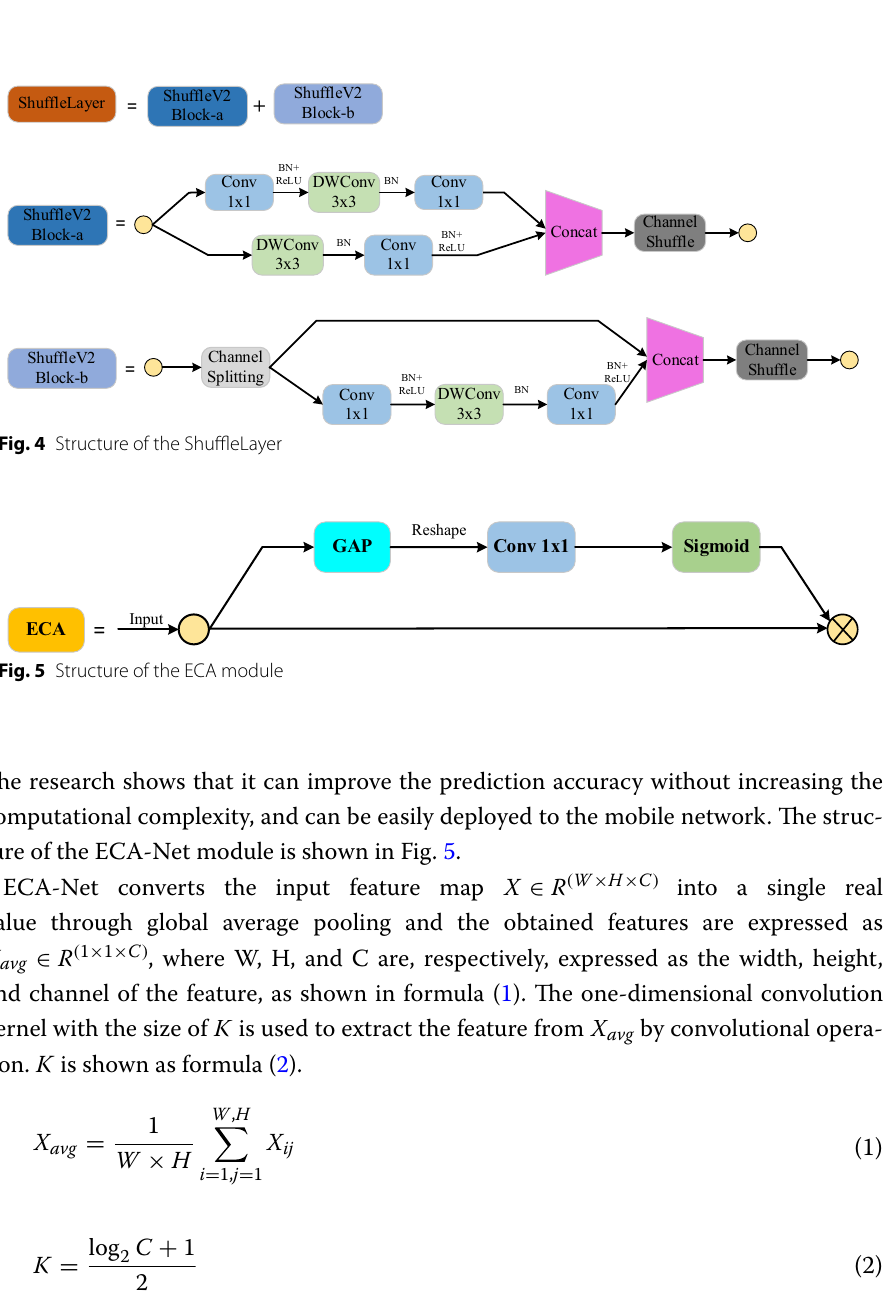
Fig. 4 Structure of the ShuffleLayer